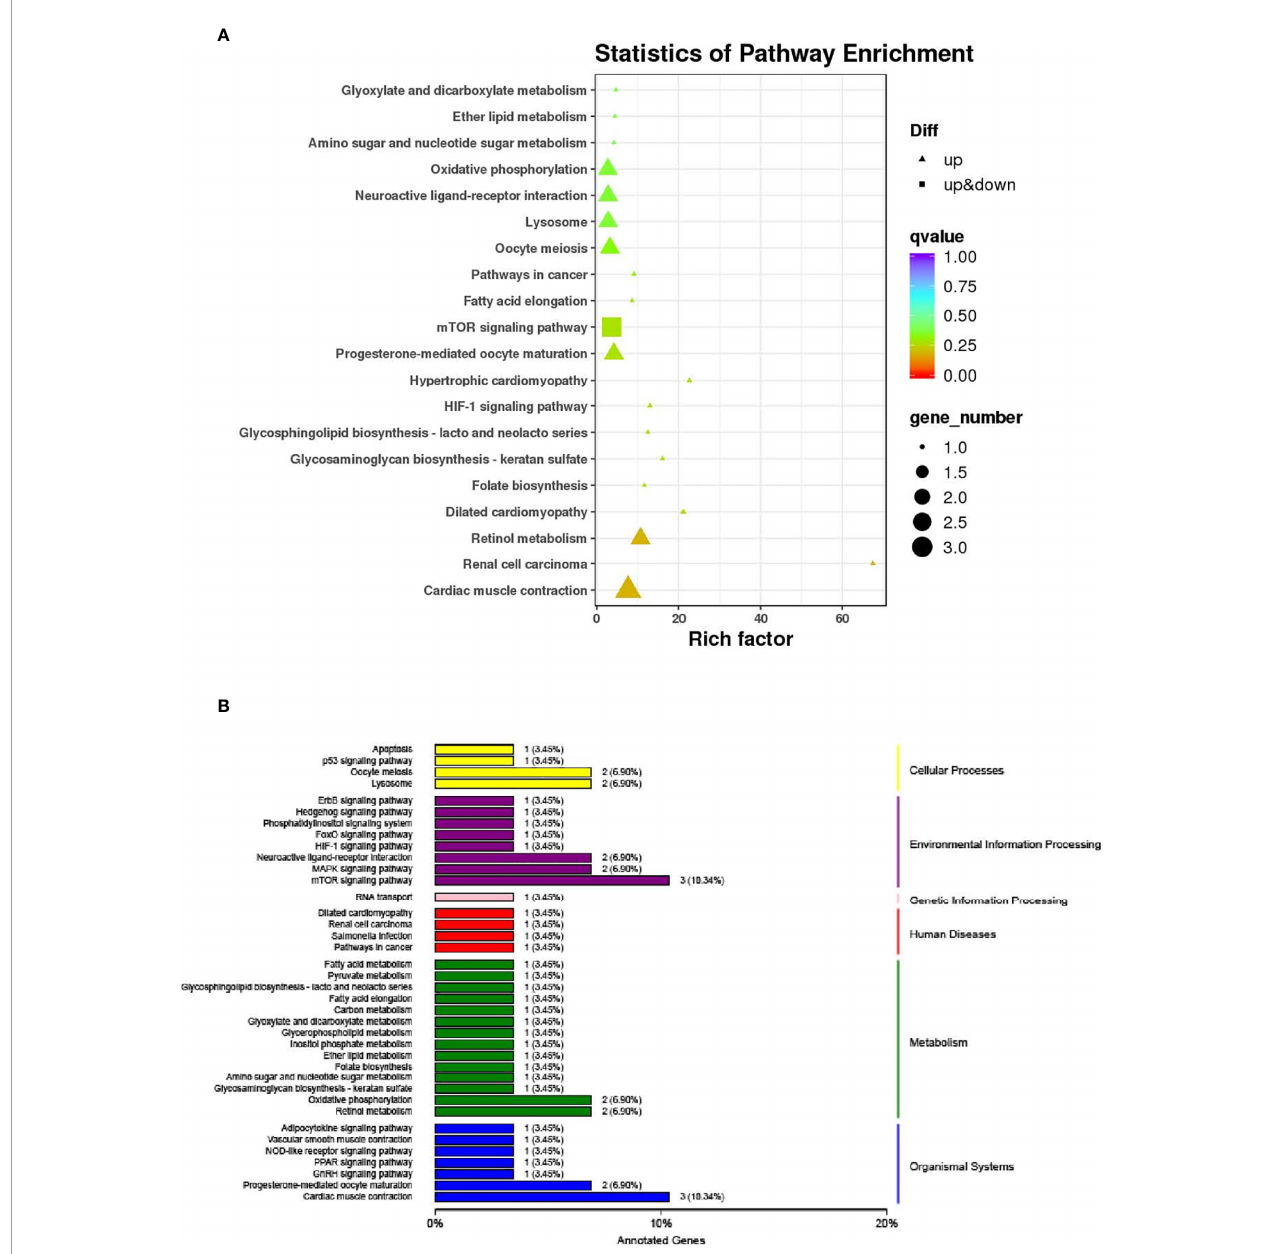
FIGURE 6 | The top 20 signi fi cantly enriched KEGG pathways of differentially expressed genes (DEGs). (A) The pathways and rich factor are shown in the vertical and the horizontal axis, respectively. The dot size indicates the number of genes and the color indicates the q-value. (B) Classi fi cation of differentially expressed genes KEGG. The vertical axis is the name of KEGG metabolic pathway, the left part is the speci fi c pathway name, and the right part is the classi fi cation category corresponding to each pathway. And the horizontal axis is the Annotated Genes. The number on the column is the number of differentially expressed genes related to this pathway. The same column color represents the same